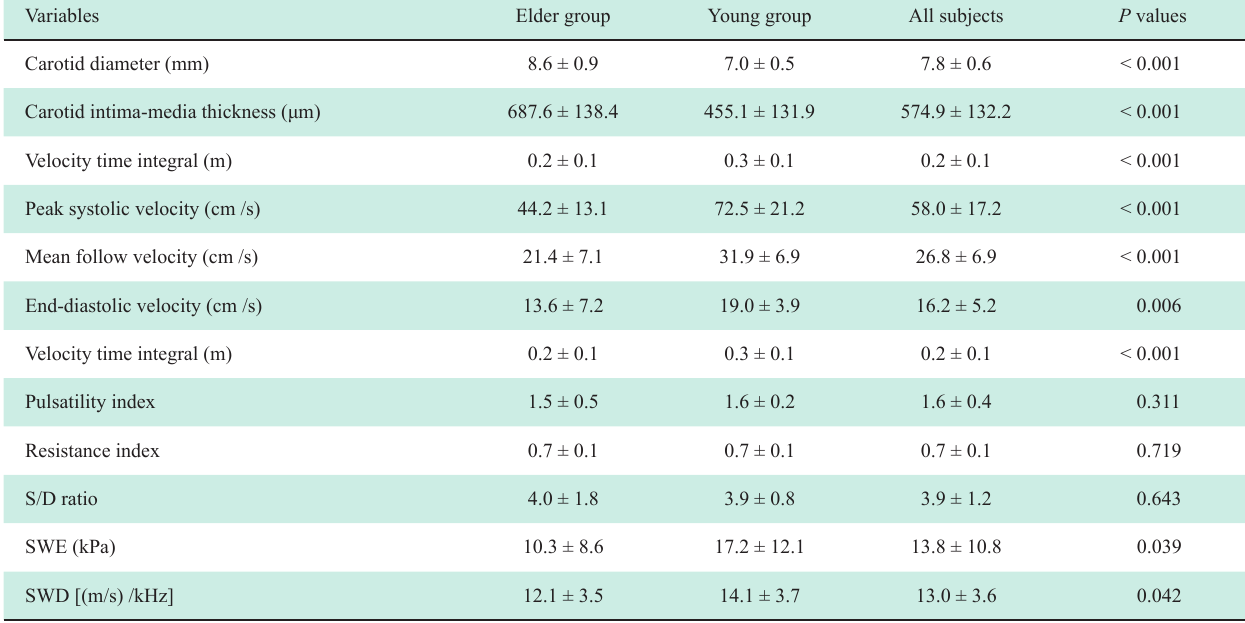
Table 2 Characteristics of individuals with carotid ultrasound measures in two groups Variables Elder